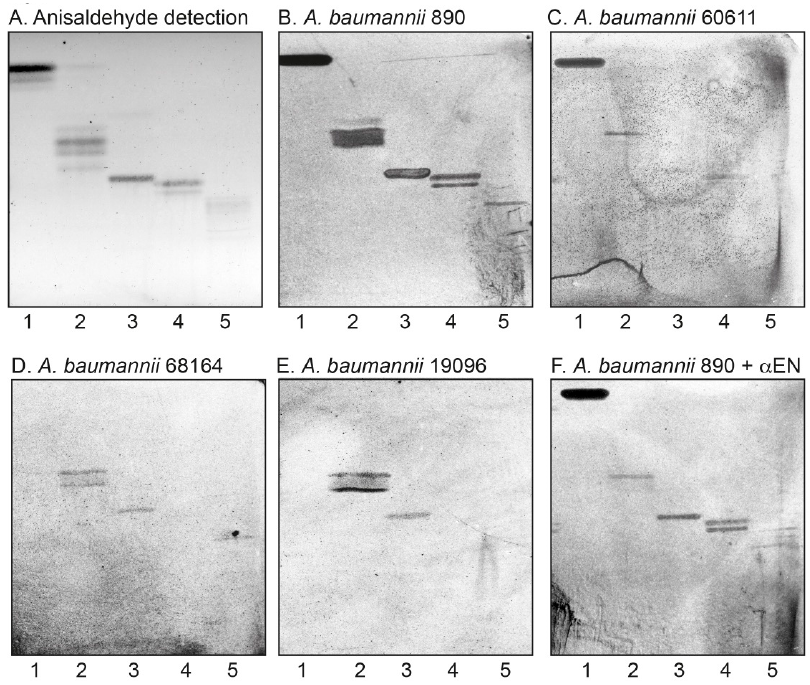
Figure 5. Binding of A. baumannii to glycosphingolipids on thin-layer chromatograms. Chemical detection by anisaldehyde ( A ) and autoradiograms obtained by binding of A. baumannii strain CCUG 890 ( B ), A. baumannii strain CCUG 60611 ( C ), A. baumannii strain CCUG 68164 ( D ), A. baumannii strain CCUG 19096 ( E ), and A. baumannii strain CCUG 890 incubated with antibodies raised against the N-terminal domain of CsuE ( α EN) ( F ), followed by autoradiography for 12 h, as described under “Materials and Methods”. The solvent system used was chloroform/methanol/water (60:35:8, by volume). The lanes were: Lane 1, galactosylceramide (Gal β 1Cer), 4 μ g; Lane 2, lactosylceramide (Gal β 4Glc β 1Cer) with (GalNAc β 4Gal β 4Glc β 1Cer); Lane 4, lactotetraosylceramide (Gal β 3GlcNAc β 3-Gal β 4Glc β 1Cer), 2 μ g;